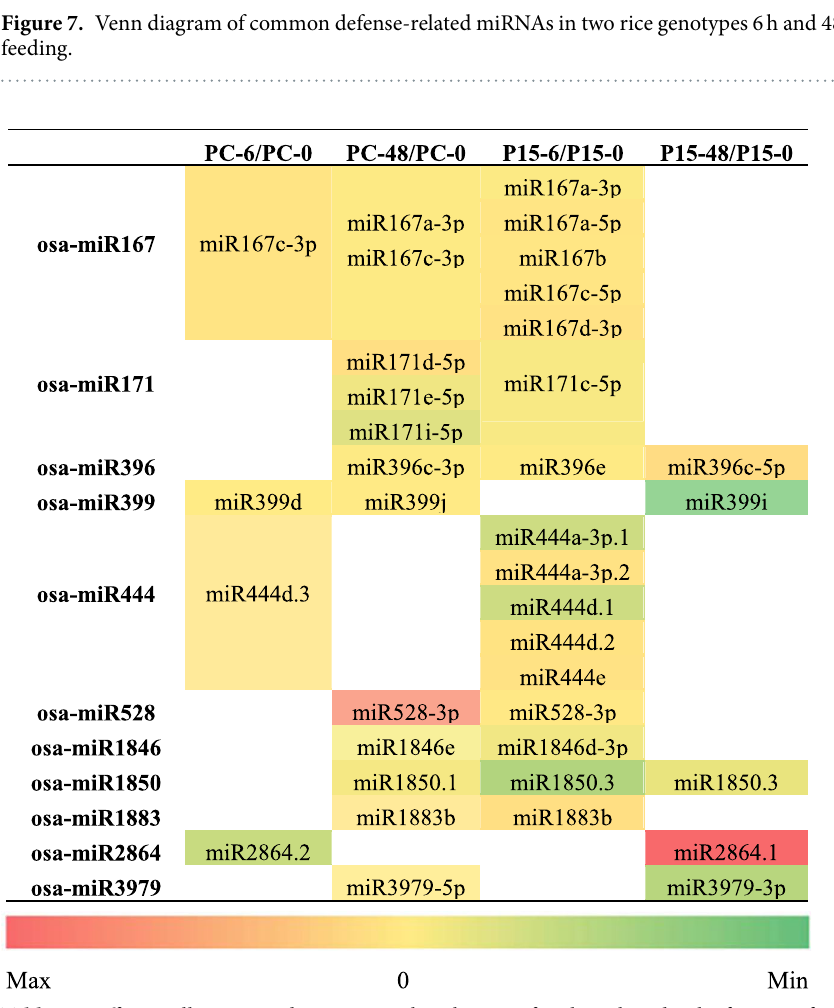
predicted novel miRNAs by quantitative stem-loop RT-PCR, only one of seven miRNAs, novel-m0494-3p, had a similar expression to the sequencing data (Fig. 4). The secondary structures of the seven novel miRNA precursors